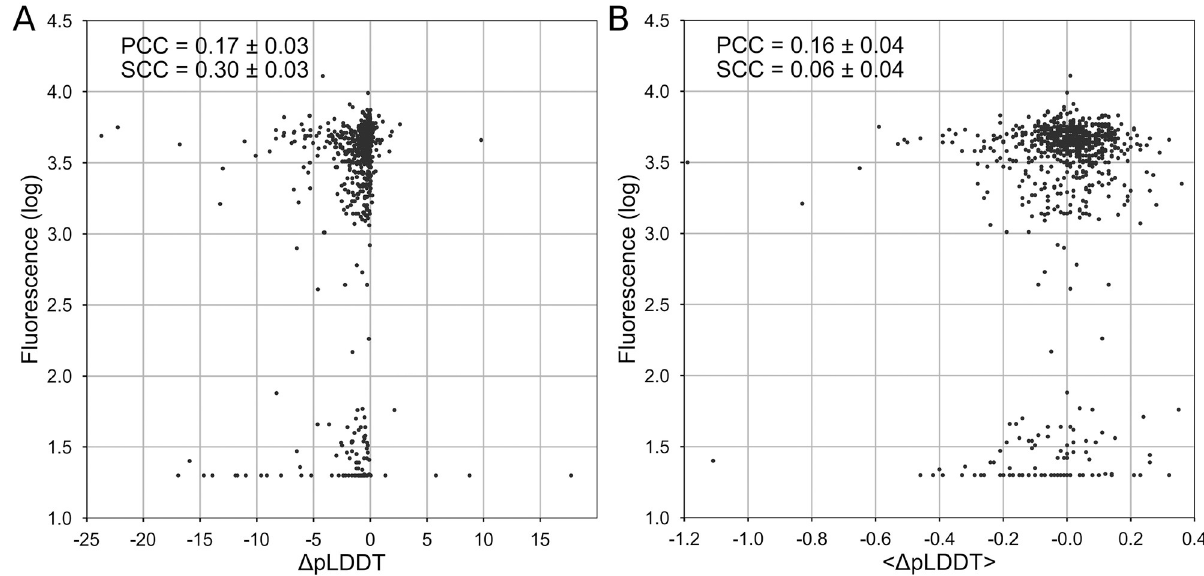
Fig 2. Correlation between the GFP fluorescence and Δ pLDDT. Correlation between the GFP fluorescence and change of confidence score of structure prediction, Δ pLDDT. A: The correlation for the mutated amino acid. B: The correlation for the whole structure.